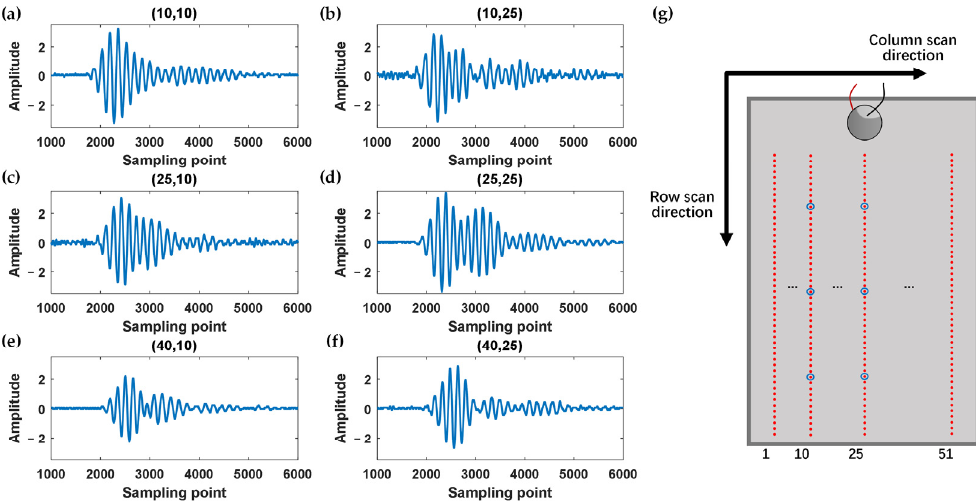
Figure 4. Time-domain waveforms of UGW signals at different positions of the battery. (The total length of time domain sampled signal is 10,000 sampling points, and the signal mainly exists in the [1000,6000] sampling interval. (10,25) represents the scanning points on the 10th row and 25th column in the scanning area, and so on. The ultrasound excitation source is closest to the (1,25) point in the scan area. The scan positions corresponding to ( a – f ) are shown in ( g ).)